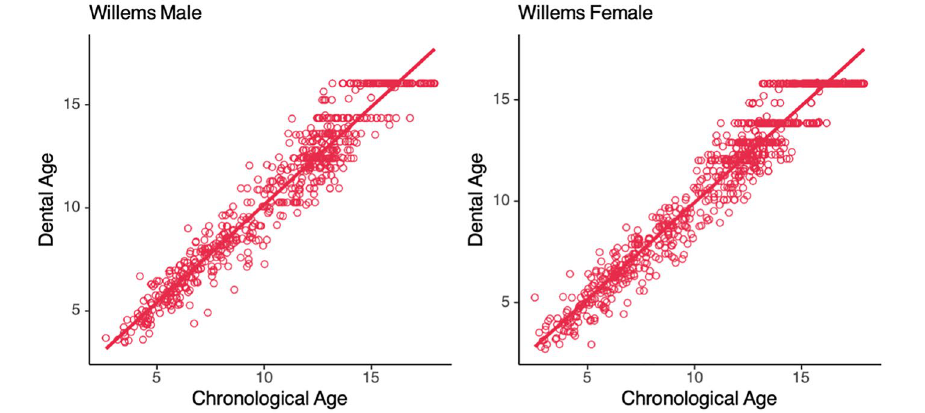
Figure 2. Distribution of chronological age and dental age ( Willems